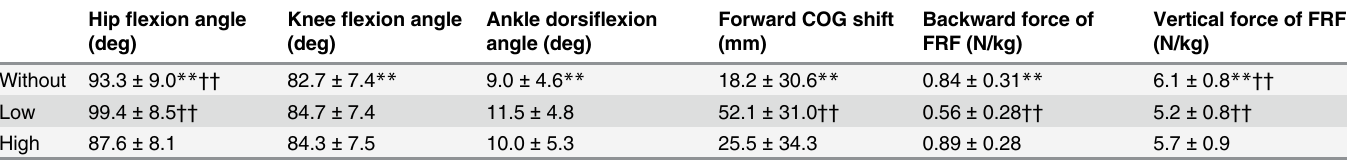
These values are data at seat-off moment. The forward shift of the COG was calculated as positions relative to the ankle joint. The mean and standard deviation are shown. Note. COG, Center of Gravity; FRF, Floor Reaction